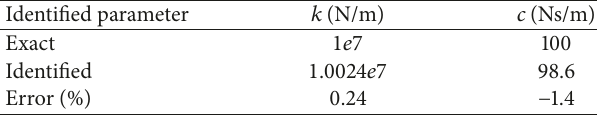
Table 2: Comparisons of identified